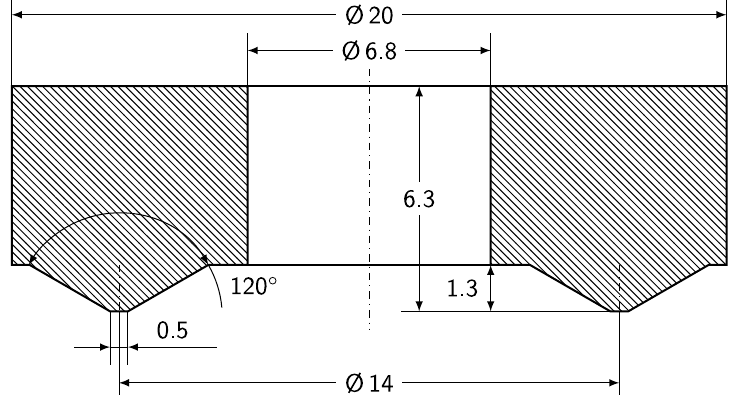
Figure 2. Technical drawing of the investigated ring projection.